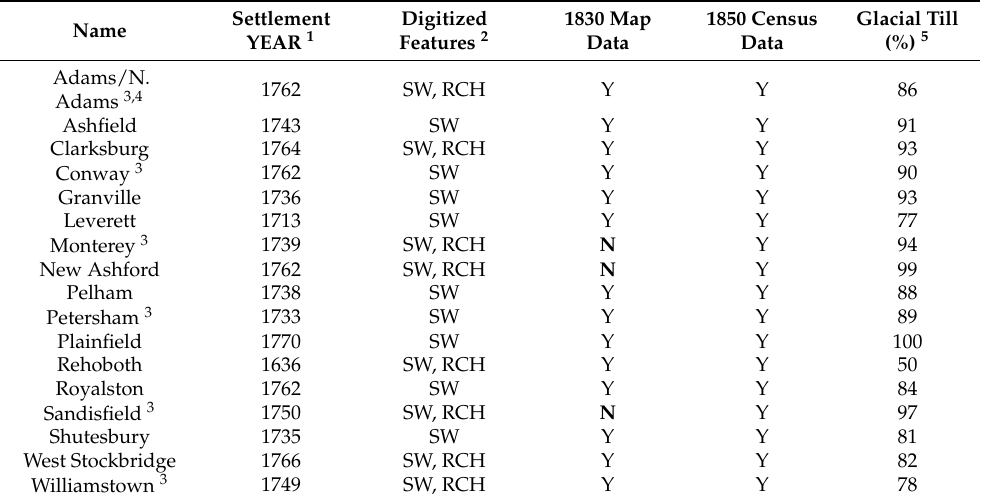
Figure 3. Overview of study town locations in Massachusetts. Change in improved farmland (km 2 ) from 1850 to 1870 is indicated for each town, compiled from U.S. Census Nonpopulation Schedule for Agriculture data [25,26]. Map projection is NAD 1983 UTM Zone 18N. Table 1. Overview of study towns, including data availability and characteristics of glacial deposits.